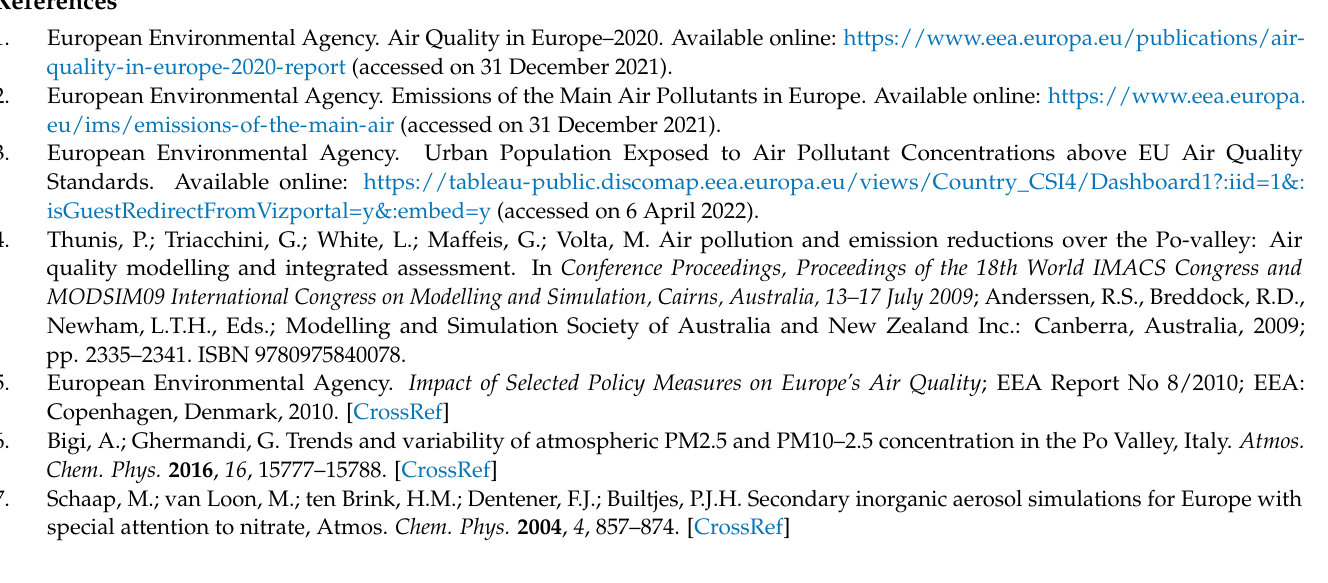
height (monthly average) in Torino (IT), Essen (DE) and Katowice (PL) average values from 1979 to 2020. Figure S4: Correlation between PBL height and PM 10 daily averages measured in Torino (N-W Italy) in the period 2011–2020. Figure S5: Mean sea level pressure diurnal pattern in Torino (North Western Italy), Essen (North Western Germany) and Katowice (Southern Poland) during the cold season (average values from 1979 to 2020). Table S1. Emission reduction in the main air pollutants by Member State from 2005 to 2019. Table S2: Emissions of main atmospheric pollutants in the Po Basin (Piedmont + Lombardy + Emilia Romagna + Veneto) and other European